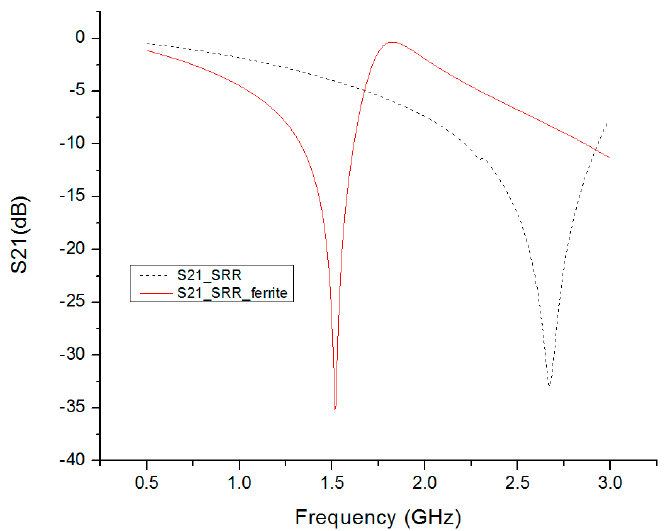
Figure 4. Simulation results of the S21 parameter of the SRR unit cell and SRR-ferrite unit cell. The resonant frequency of the SRR unit cell was about 2.68 GHz. For the SRR unit cell loaded by ferrite, the resonant frequency was about 1.5 GHz.